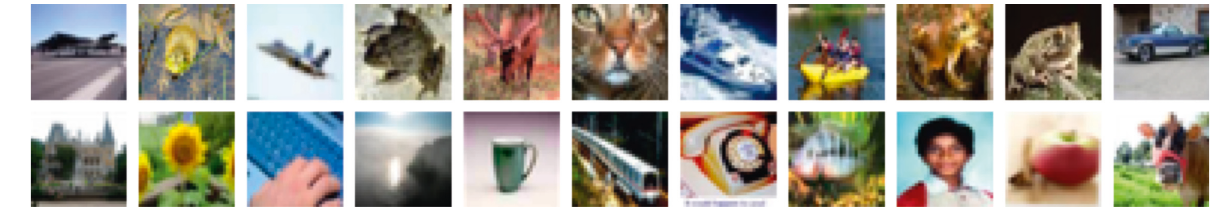
Figure 4: Some examples of images in CIFAR-10 (first row) and CIFAR-100 (second row).